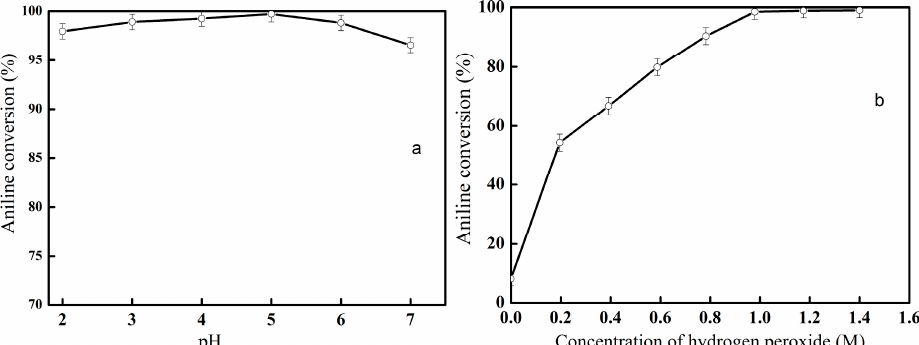
Figure 5. Effect of pH and concentration of hydrogen peroxide on the conversion of aniline. ( a ) Effect of pH conditions on the conversion of aniline; ( b ) Effect of hydrogen peroxide on the oxidation of aniline.